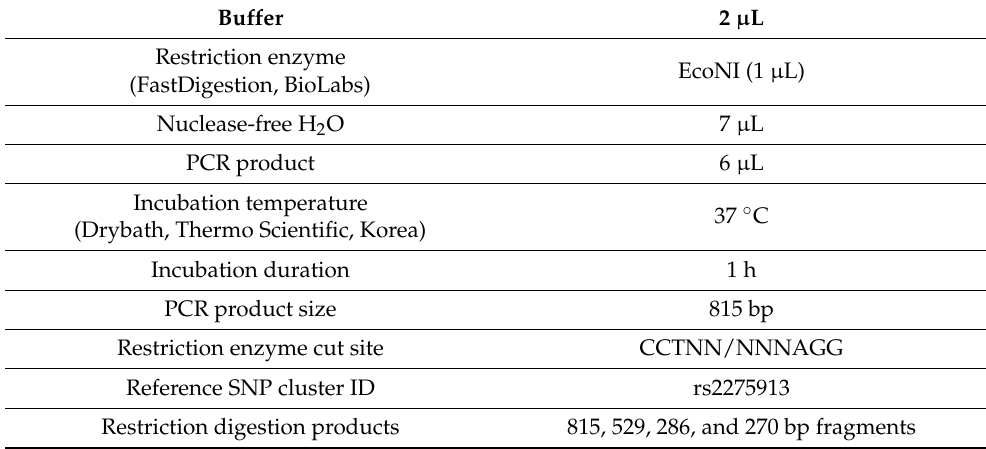
Table 1. Genotyping information and protocol for studying the IL17A SNP.